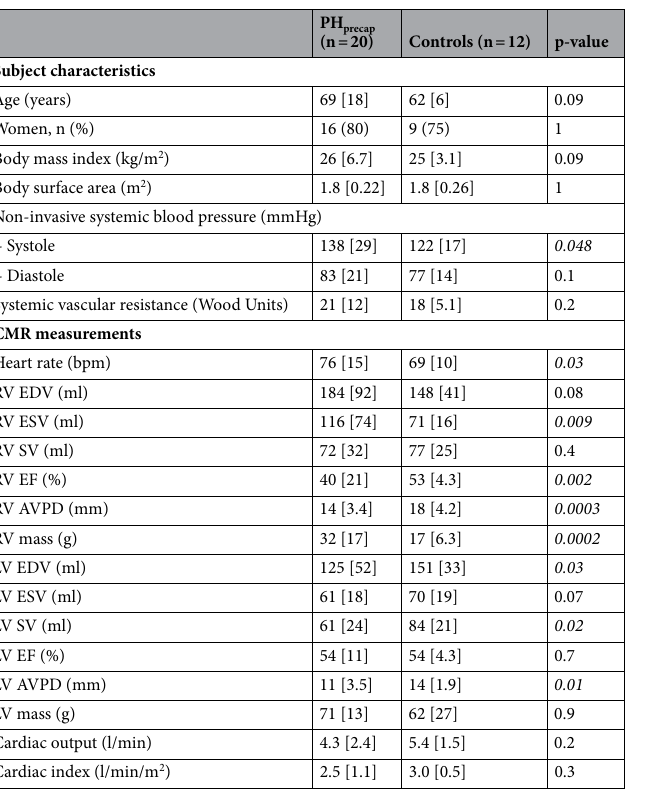
Table 2. Cardiac volumes and functional measures from CMR . Significant values are in [italics]. Data is expressed as median and interquartile range [IQR]. PH precap , precapillary pulmonary hypertension; CMR, cardiac magnetic resonance; bpm, beats per minute; RV EDV, right ventricular end-diastolic volume; ESV, end- systolic volume; SV, stroke volume; EF, ejection fraction; AVPD, atrioventricular plane displacement; LV, left